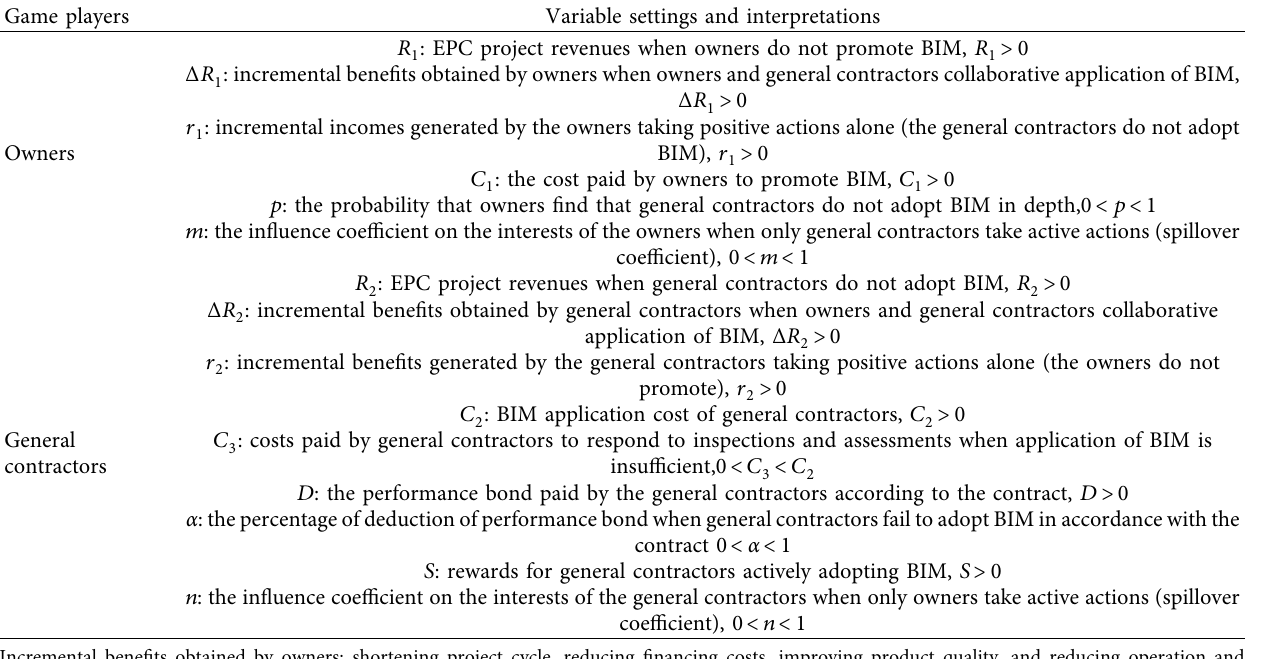
Table 1: Variable settings and interpretations.